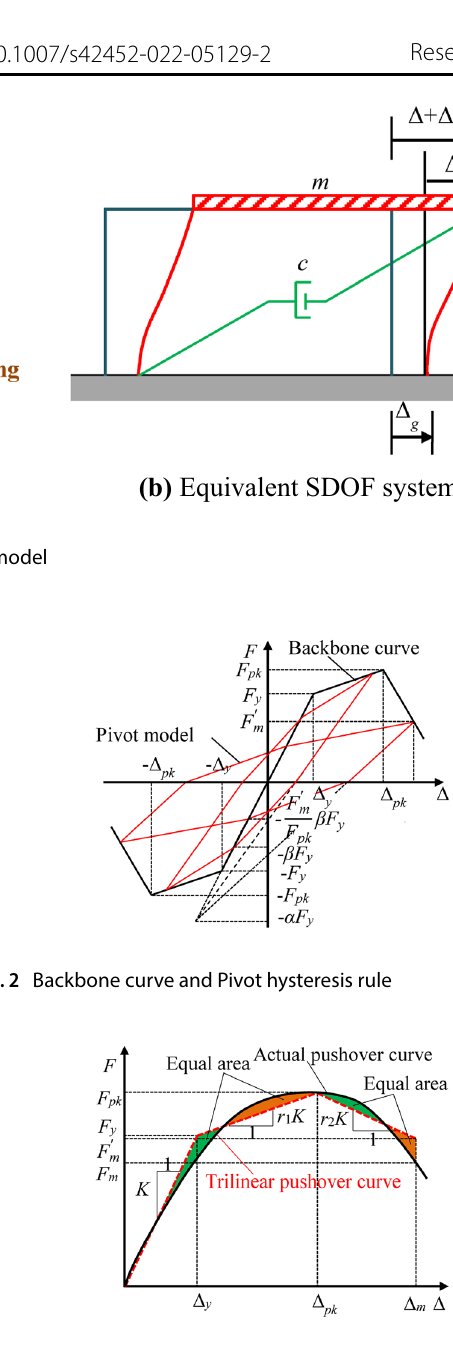
Fig. 3 Determination of backbone